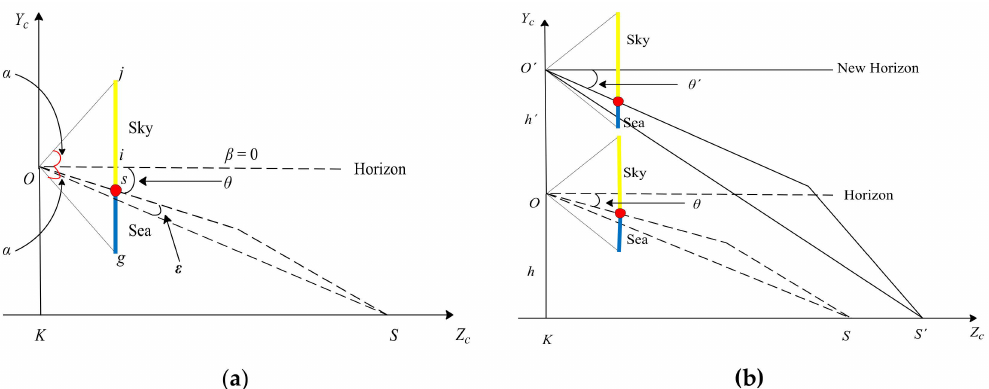
Figure 3. Geometric relationship between the sea–sky line (SSL) position and the camera position. ( a ) Geometric relationship under the initial state. ( b ) Geometric relationship under the camera heaving